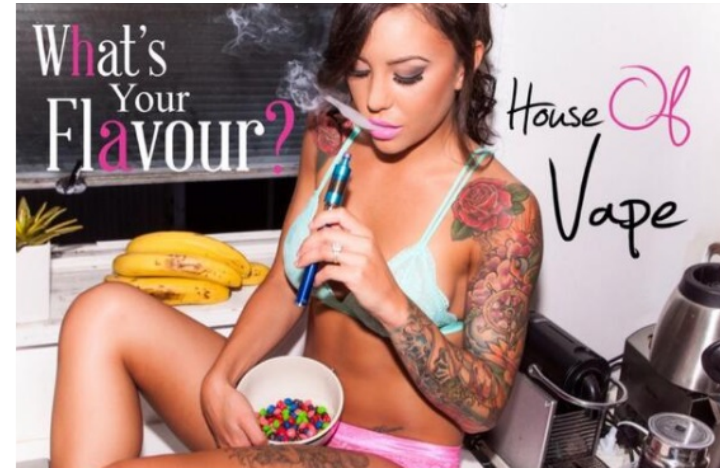
Figure 10. Example of a sexualized image within the "behaviors and practices" domain.